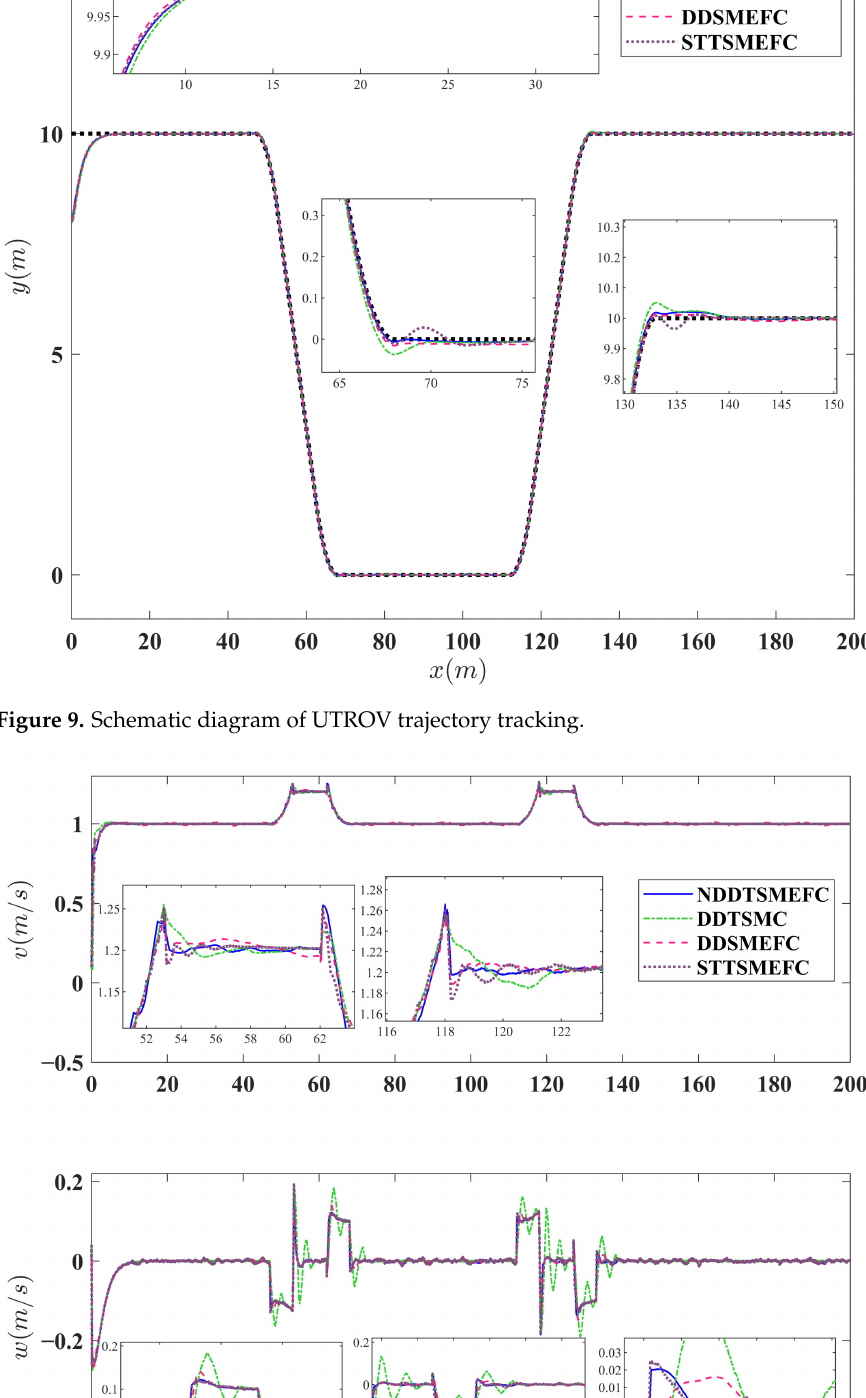
Figure 10. Schematic diagram of UTROV system output (Velocity).